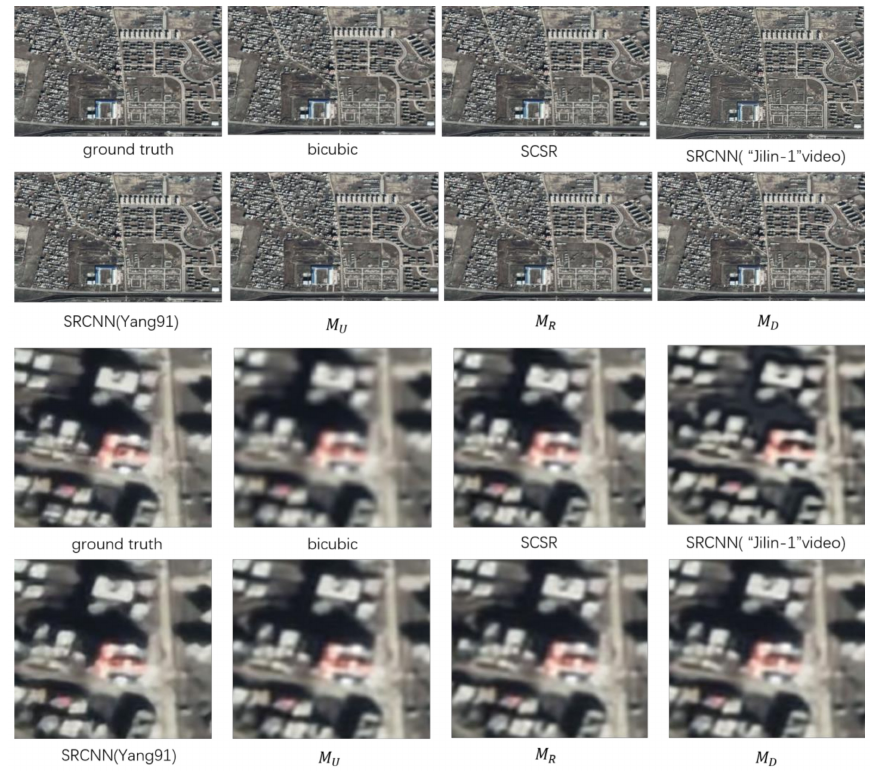
Figure 5. Reconstructed images and details of Kabul in Afghanistan. M U , M D , and M R represent three kinds of different networks, respectively (see Section 2.1). SCSR = sparse